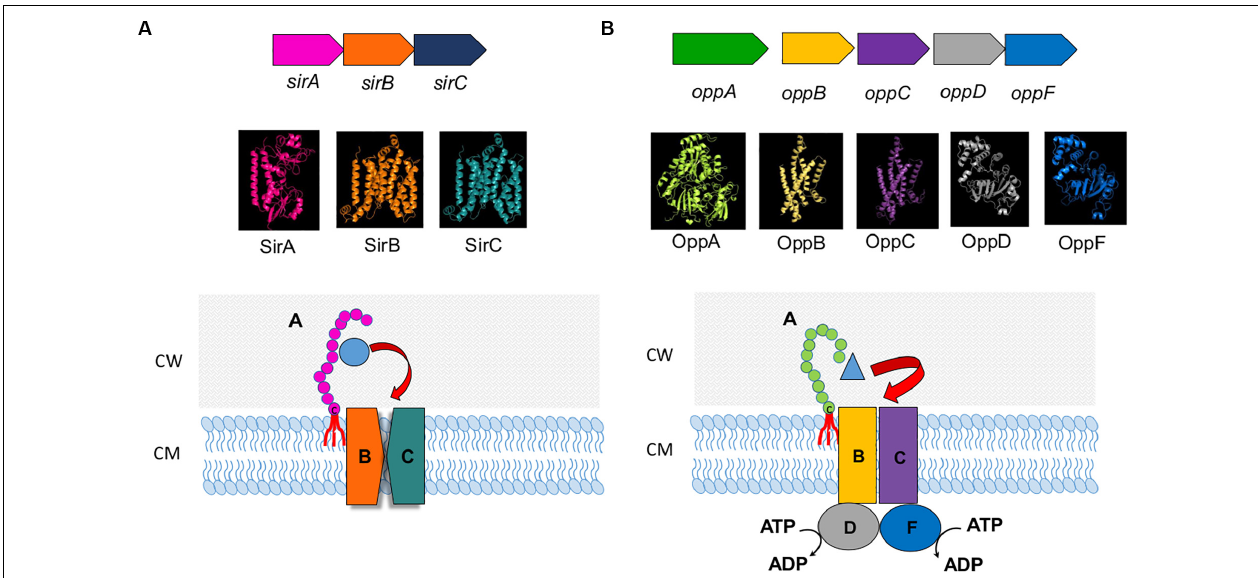
FIGURE 2 | ABC transport system. (A) sirABC ion transport system. Upper panel illustrates the operon in Staphylococcus aureus (Dale et al., 2004). Middle panel presents 3D models of SirA, SirB, and SirC. 3D crystal model of SirA was downloaded from protein data bank (PDB ID: 3MWF) and visualized in PyMoL software (DeLano, 2009). Phyre2 (Kelley et al., 2015) was used to predict the 3D configuration of SirB and SirC. The Phyre2 predition showed 8 transmembrane motifs in both SirB and SirC ranging from 14 to 324 amino acids in SirB and 16 to 326 amino acids in SirC. There were 2 re-entrant helices which connect the 5th to 6th and 6th to 7th transmembrane motifs in both SirB and SirC. Superimposition of SirB to SirC in PyMoL showed high similarity in the 3D structure of SirB and SirC. The lower panel is the illustration of the SirABC transport system for Fe-staphylobactin (green circle). (B) OppABCDF oligopeptide transport system. The upper panel illustrates the operon in Bacillus subtilis (Perego et al., 1991). Middle panel presents 3D models of OppA, B, C, D and F. Phyre2 (Kelley et al., 2015) was used to predict the 3D configuration of OppA, OppB, OppC, and OppD. 3D crystal model of OppF was downloaded from protein data bank (SMR ID: P24137) and visualized in PyMoL software (DeLano, 2009). The Phyre2 predition showed 6 transmembrane motifs in both OppB and OppC ranging from 6 to 297 amino acids in OppB and 43 to 291 amino acids in OppC. Superimposition of OppB and OppD to OppC and OppF in PyMoL showed high similarity in the 3D structure of OppB and OppC, and OppD and OppF, respectively. The lower panel is the illustration of the OppABCDF transport system for oligopeptide (blue